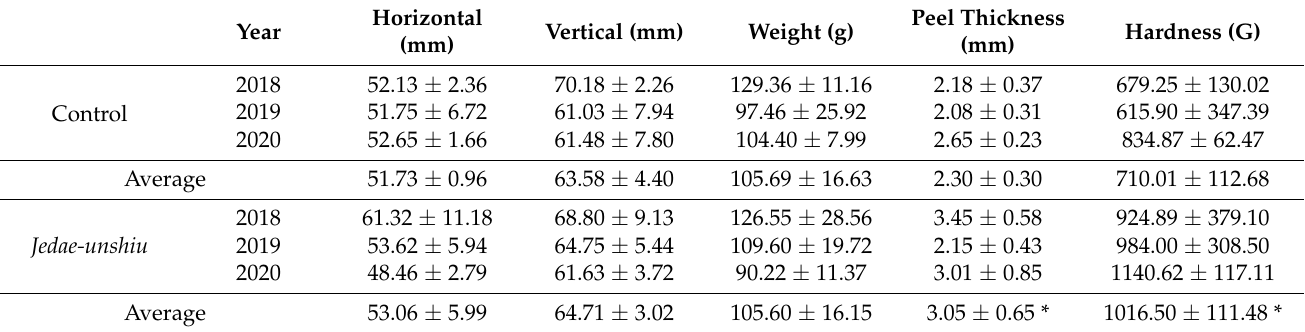
* indicates a value with a significant difference compared to the control ( p <